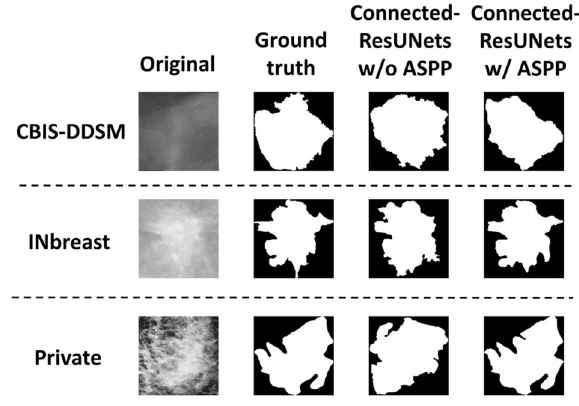
Fig. 4 Examples of the segmentation results for the proposed architecture Connected-ResUNets comparing with and without using ASPP block. Top row shows an example of original mammogram from CBIS-DDSM dataset. Middle row shows an example of original mammogram from INbreast dataset. Bottom row shows an example of original mammogram from the private dataset. Each original mammogram indicates its corresponding ground-truth (binary) image, and segmentation output image of the Connected-ResUNets without including the ASPP block vs a segmentation output image of the Connected- ResUNets with including the ASPP